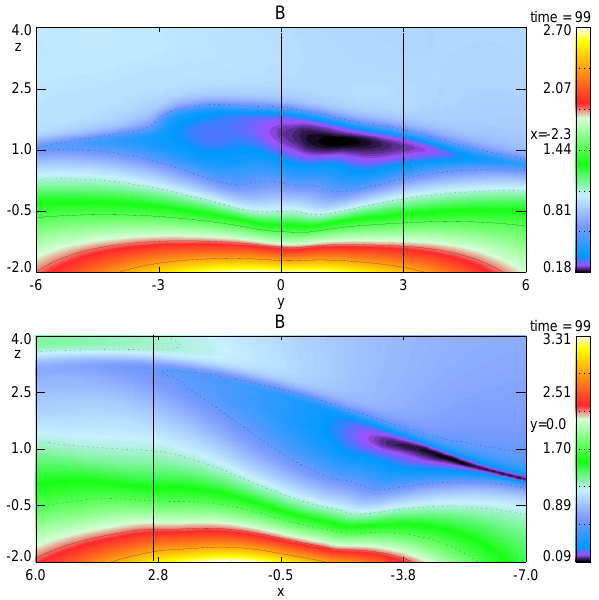
Fig. 9. Total magnetic field ( | B | ) in the y-z plane (top), and x-z plane (bottom) for northward IMF. The CDC region is indicated by low magnetic field magnitude. The boundary normals used to address the geometry of the outer boundary are computed approx- imately along the vertical lines in the figures (note that the cut at x = − 8 R E is not shown in the lower plot).